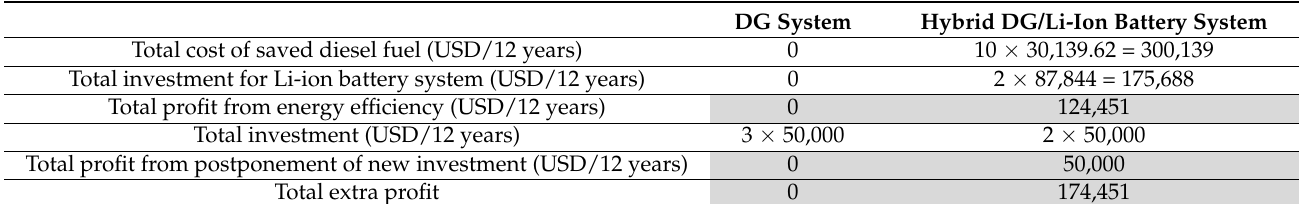
Table 5. Comparison of savings over 12